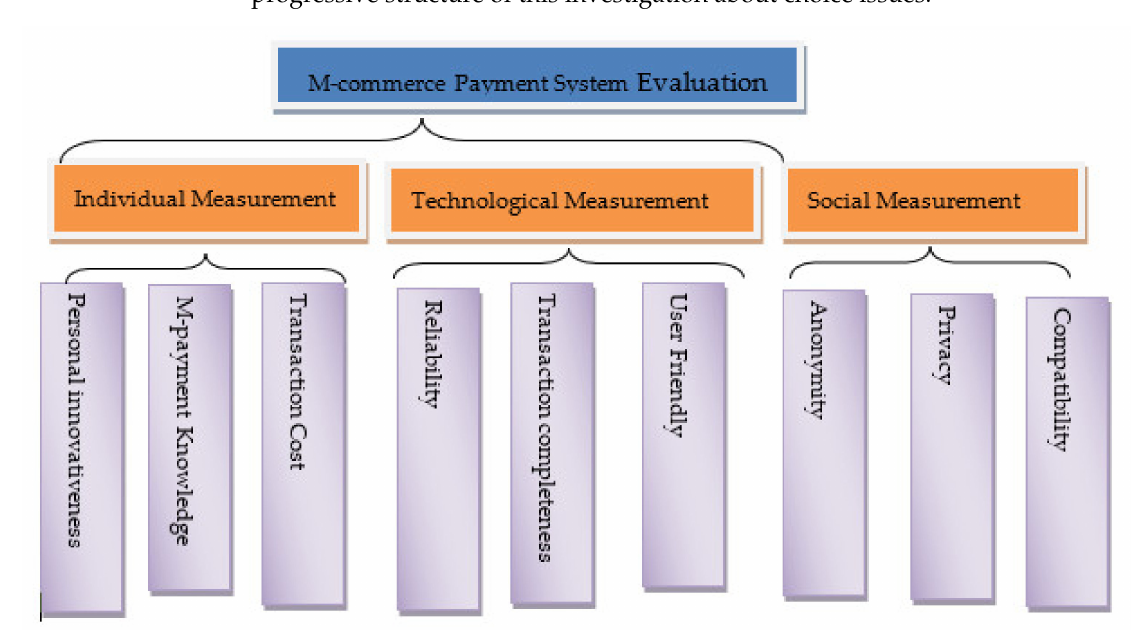
Figure 1. M-commerce payment system evaluation